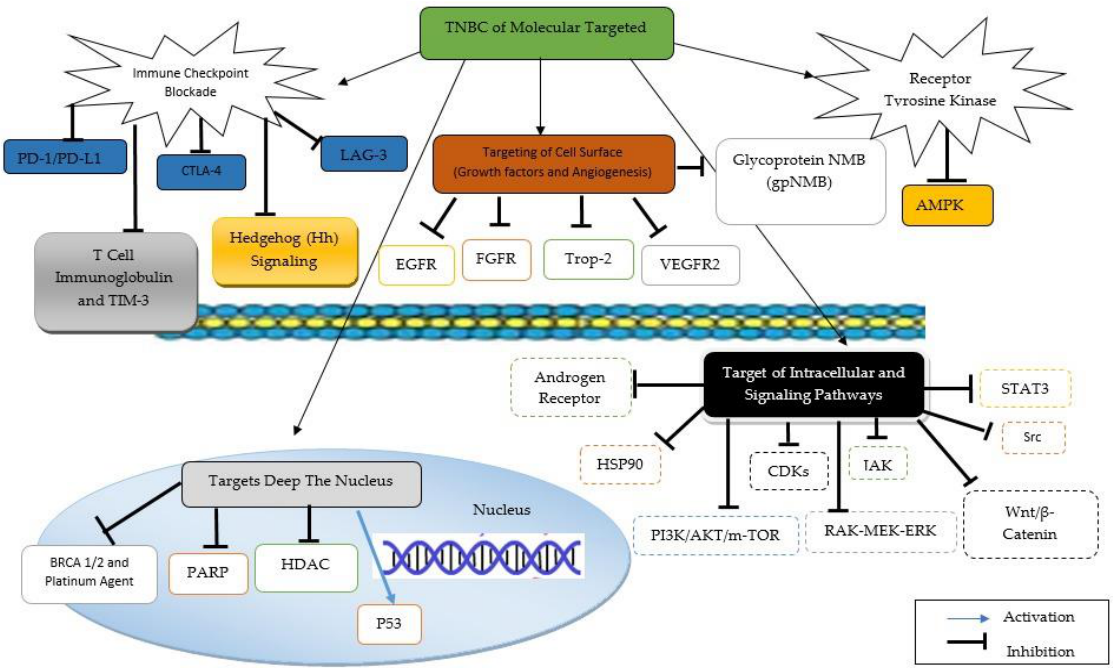
Figure 2. Mechanism of targeted therapies in TNBC.